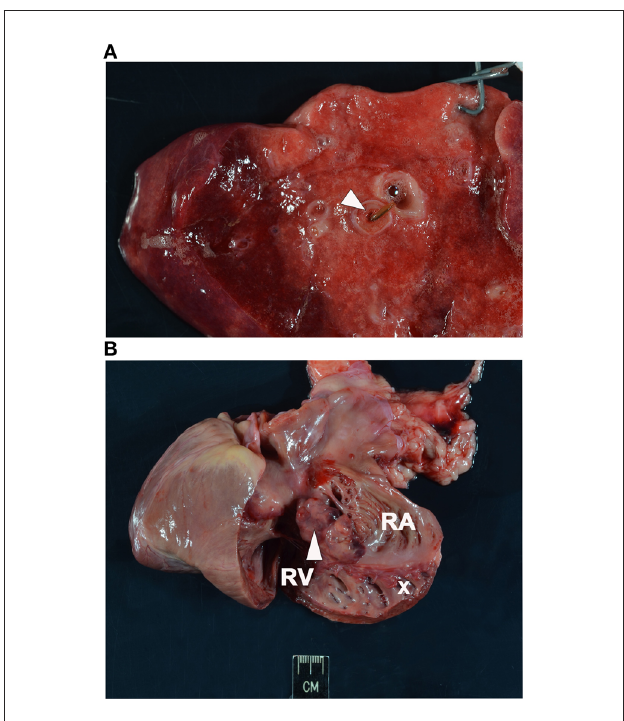
FIGURE1 Necropsy images. (A) Section of lung showing intraluminal degenerate nematode (arrowhead). (B) Section of heart with soft tissue invasion by a lobulated chemodectoma (arrowhead). The right side of the heart is opened with the right ventricle (RV) and dilated right atrium (RA) exposed and the tricuspid valve labeled